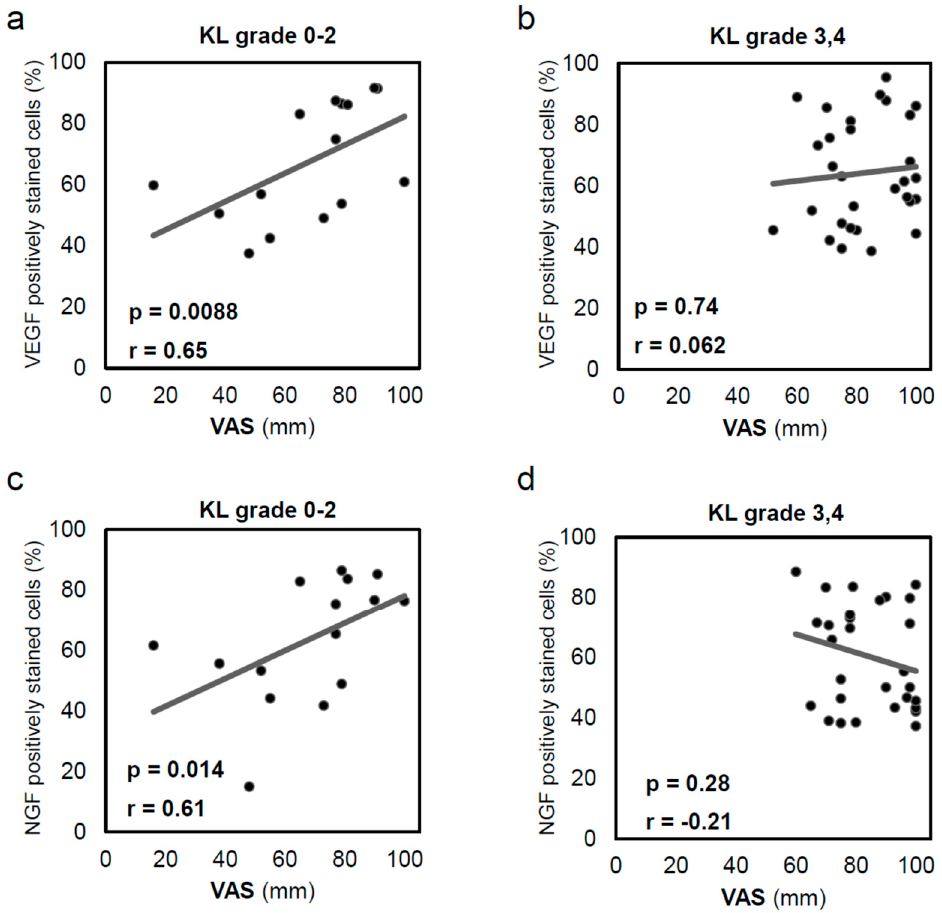
Figure 5. Correlation between inner acetabular labral VEGF expression and visual analogue scale (VAS) in patients with ( a ) Kellgren–Lawrence (KL) grade 0–2 OA (n = 15) and ( b ) KL grade 3–4 OA (n = 29). In early OA, patients reported more severe pain as VEGF expression increased. Correlation between inner acetabular labral NGF expression and VAS in patients with ( c ) KL grade 0–2 OA (n = 15) and ( d ) KL grade 3–4 OA (n = 29). In early OA, patients reported more severe pain as NGF expression increased. Correlations were analysed using Spearman’s correlation coefficient. VEGF, vascular endothelial growth factor; NGF, nerve growth factor; KL, Kellgren–Lawrence; VAS, visual analogue scale.